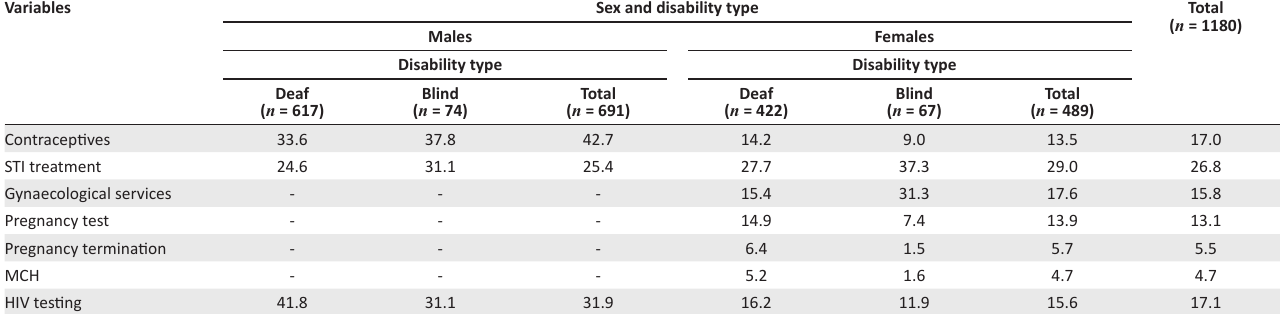
TABLE 4: Sexual and reproductive health services utilised by sex and disability type.